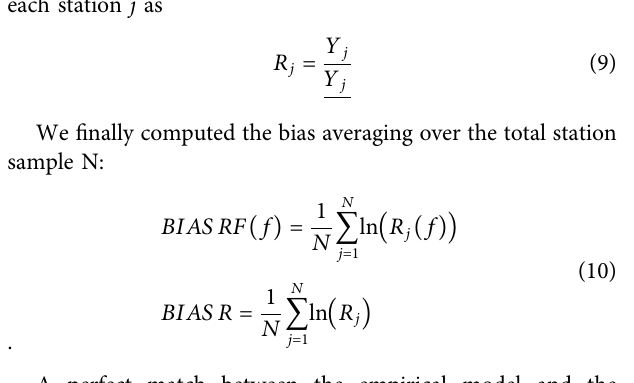
Frontiers in Earth Science |